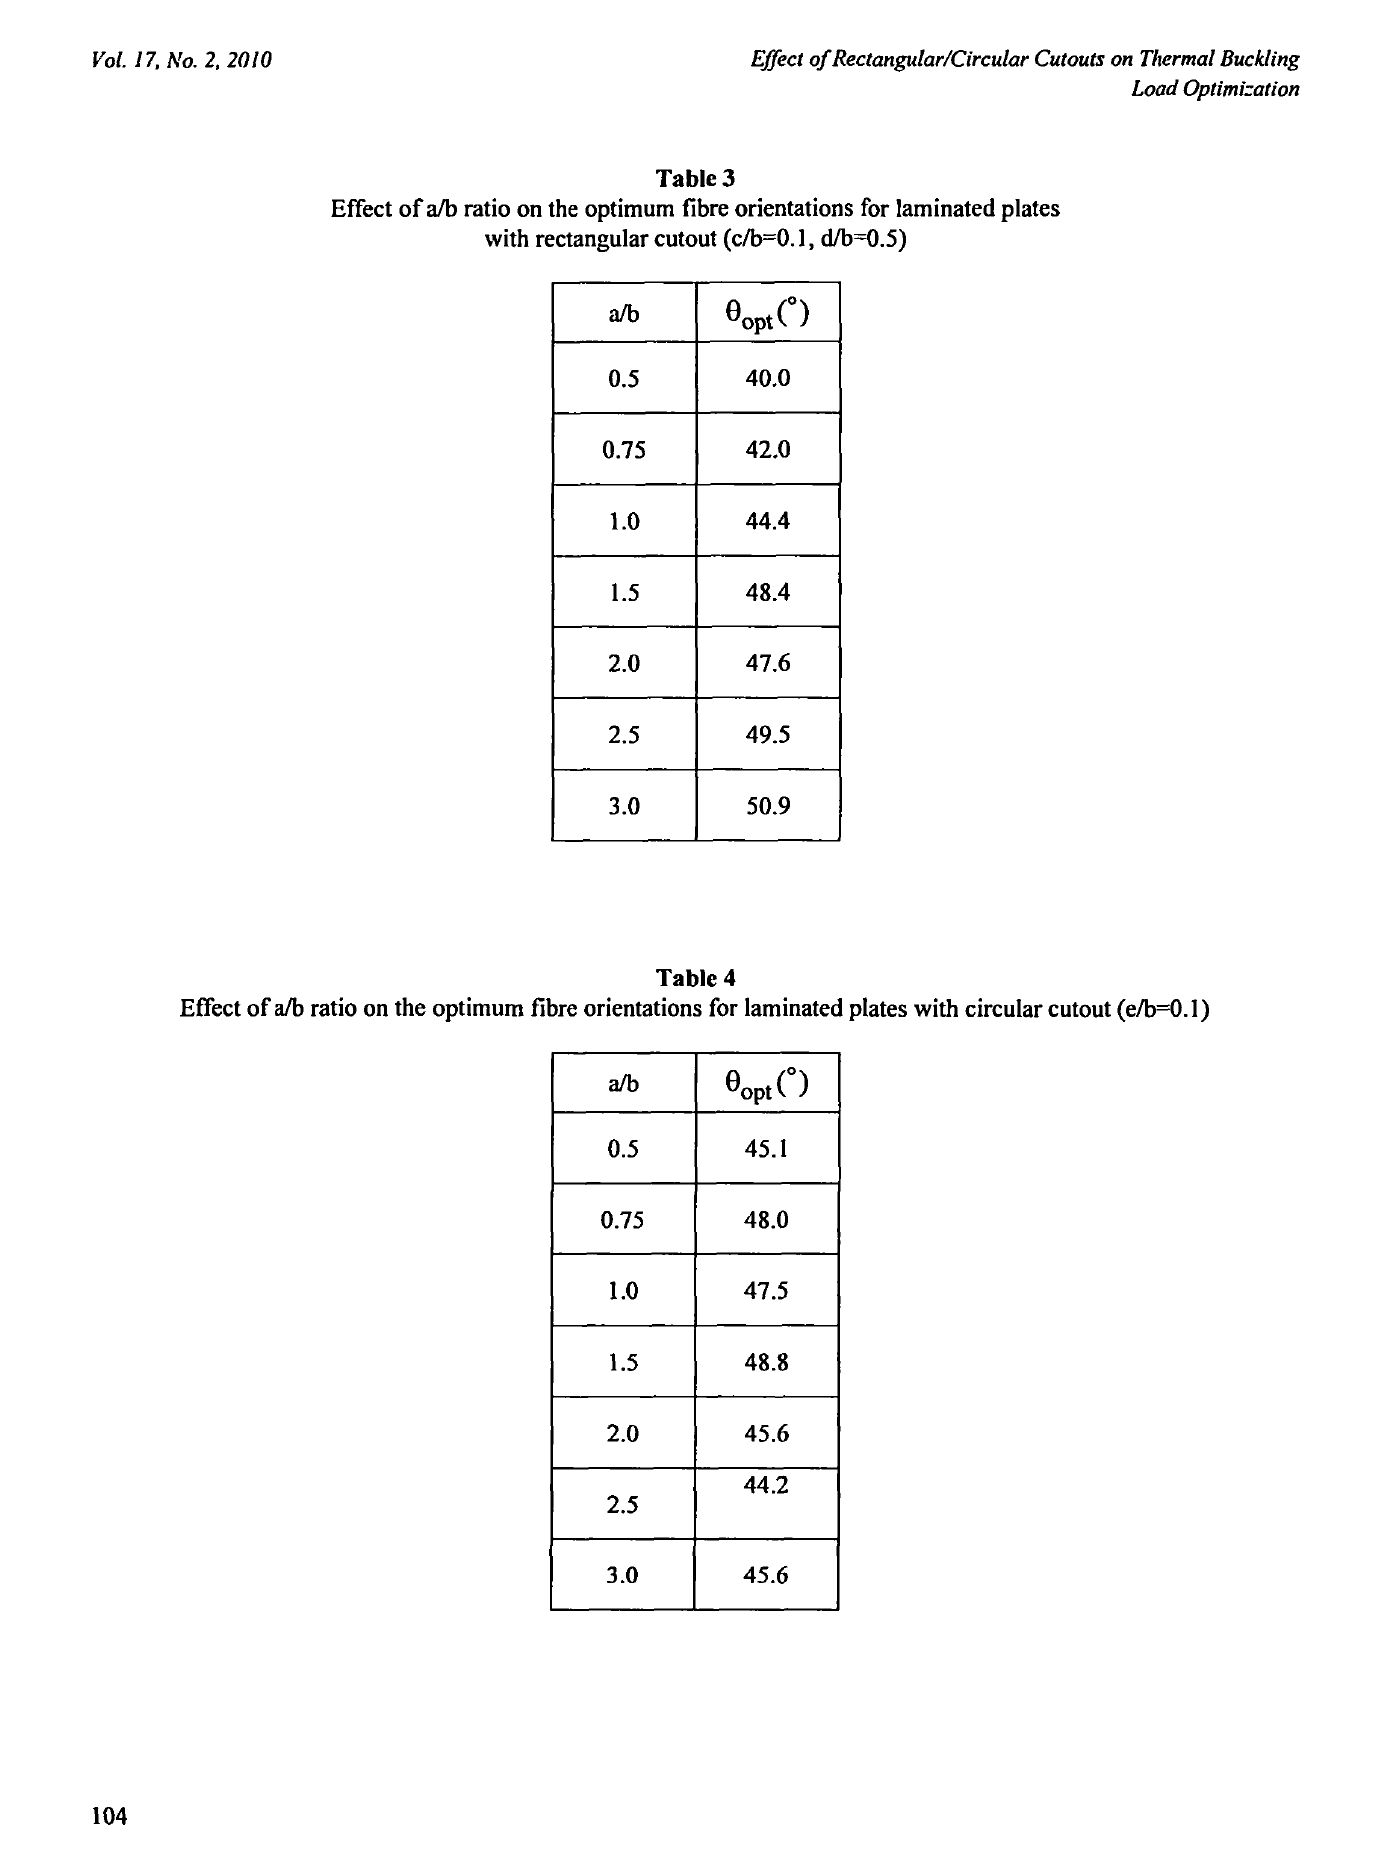
Effect of a/b ratio on the optimum fibre orientations for laminated